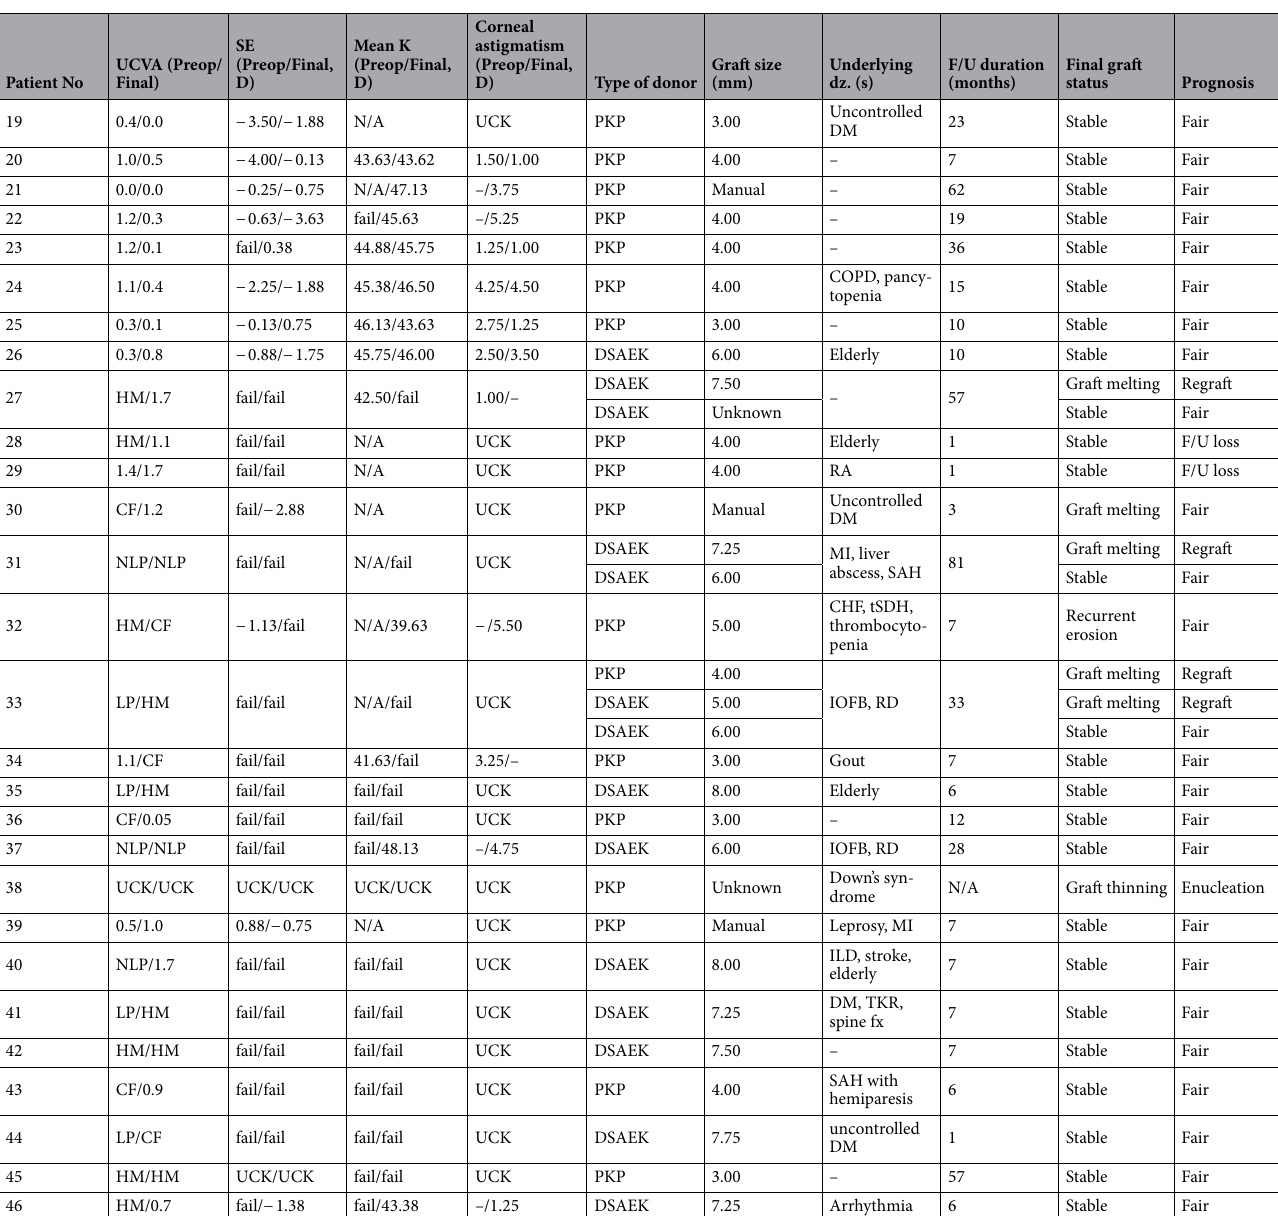
Table 5. Outcomes after tectonic keratoplasty using cryopreserved cornea. No.—number; UCVA— uncorrected visual acuity; Preop—preoperative; SE—spherical equivalent; D—diopter;